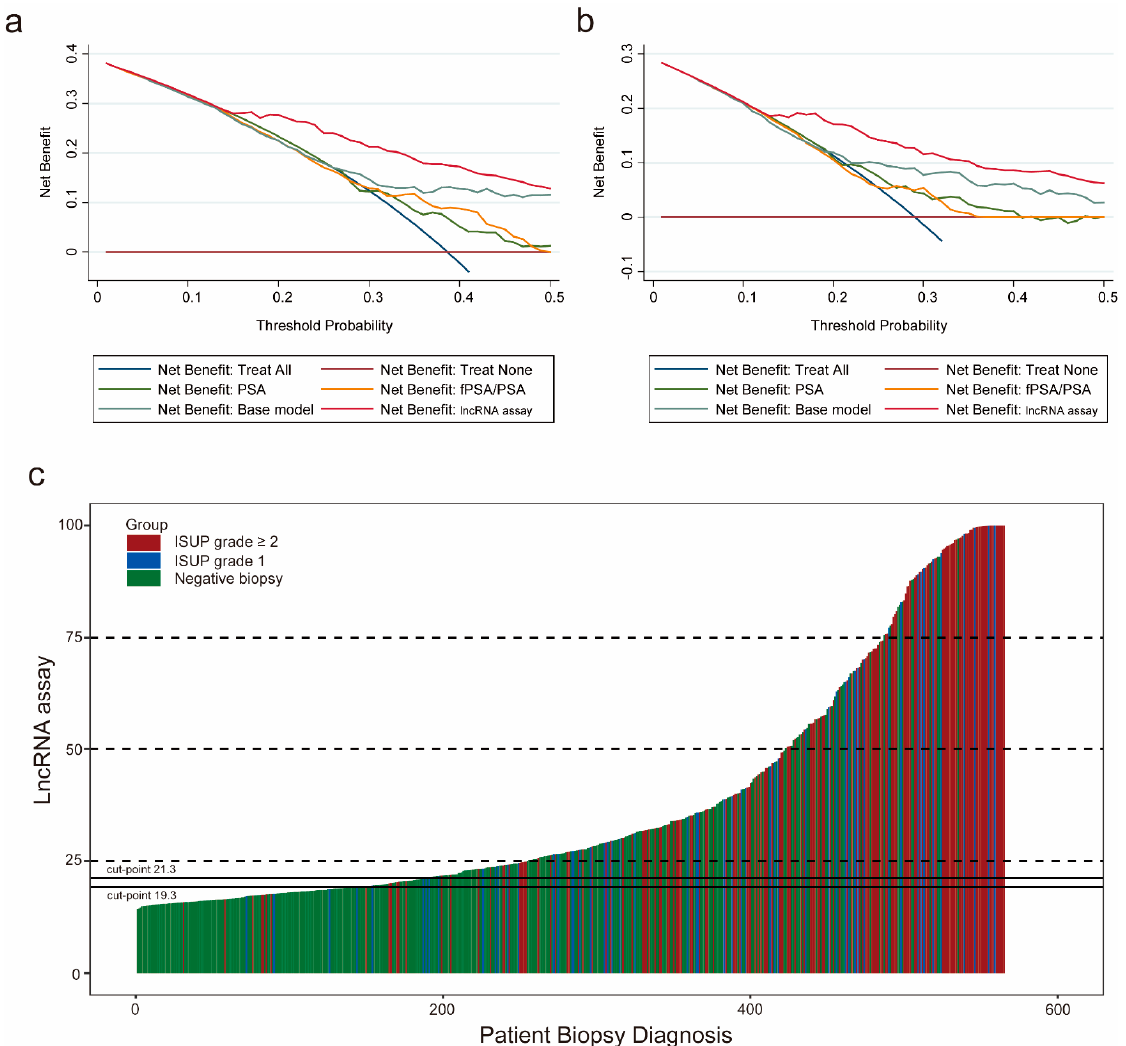
Figure 4. Clinical utility of the lncRNA assay. The decision curve analysis shows that the lncRNA assay presents the highest